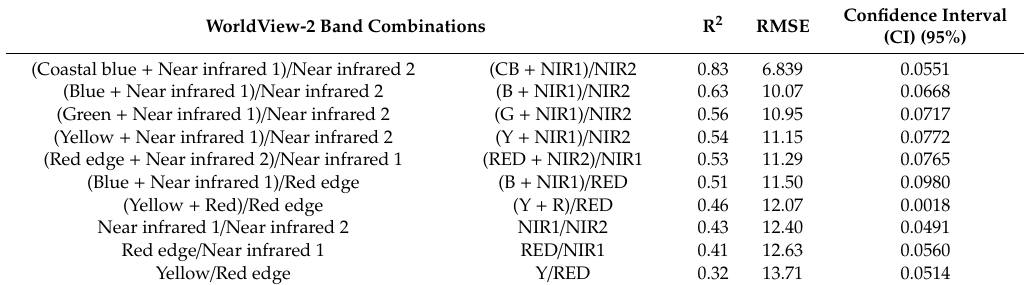
Table 2. Developed models with di ff erent band ratios and the corresponding R-squared values.